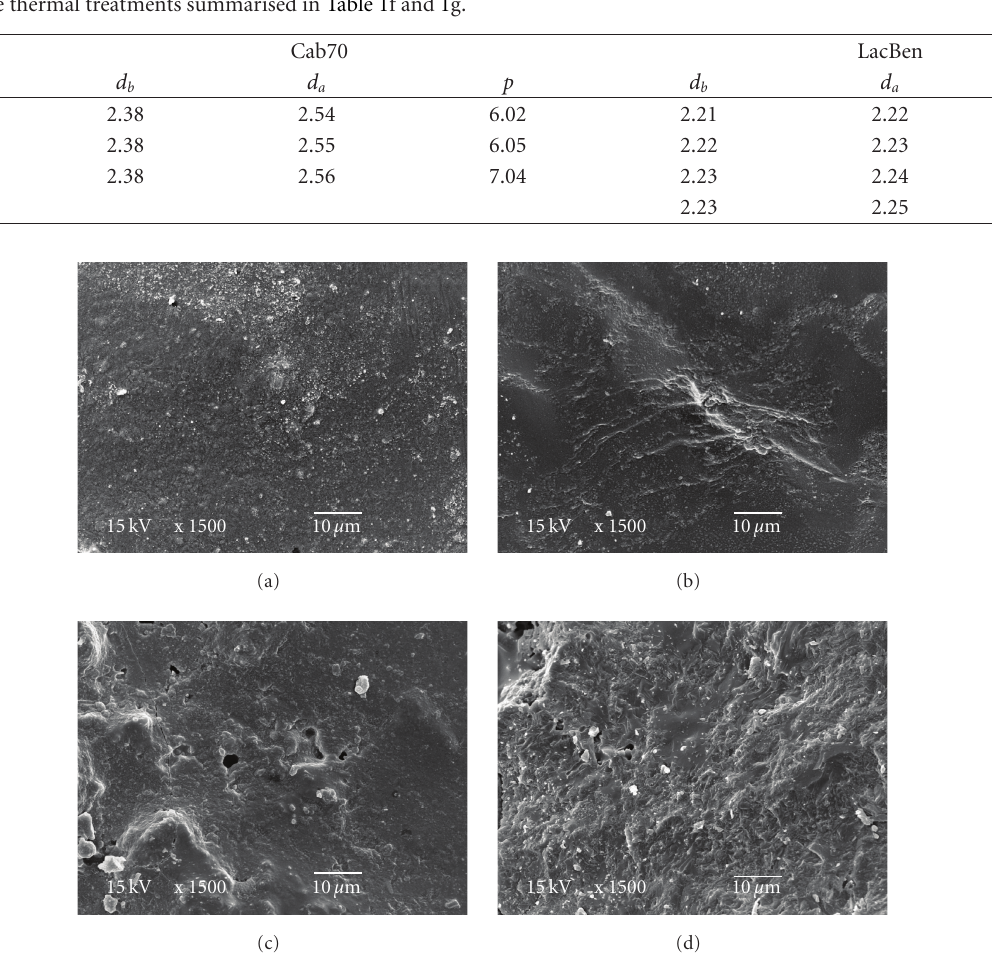
Table 5: Bulk density ( d b , g/cm 3 ), apparent density ( d a , g/cm 3 ), and porosity ( p , %) of compacts manufactured with Cab70 and LacBen according to the thermal treatments summarised in Table 1f and 1g.